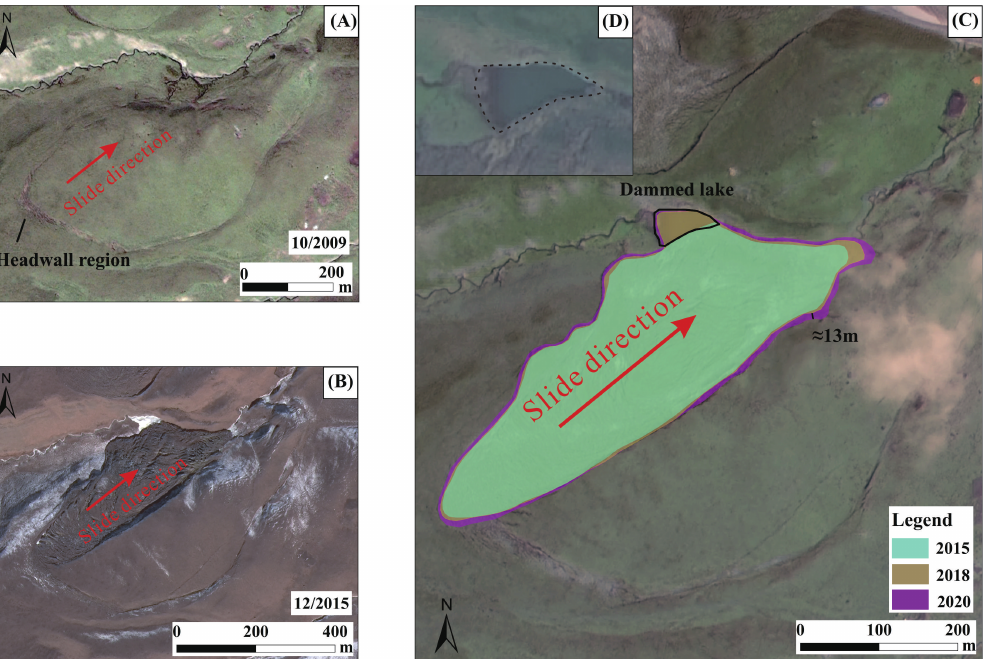
Figure 3. Temporal variations of landslide QLDT02: ( A , B ) landslide in Google satellite and Gaofen-2 satellite images from 2009 and 2015; the yellow arrow is the direction of movement of the landslide. ( C ) Landslide characteristics recorded by Gaofen-2 satellite images in 2015, 2018, and 2020. A dammed lake is formed at the toe of the slope, as shown in ( D ).